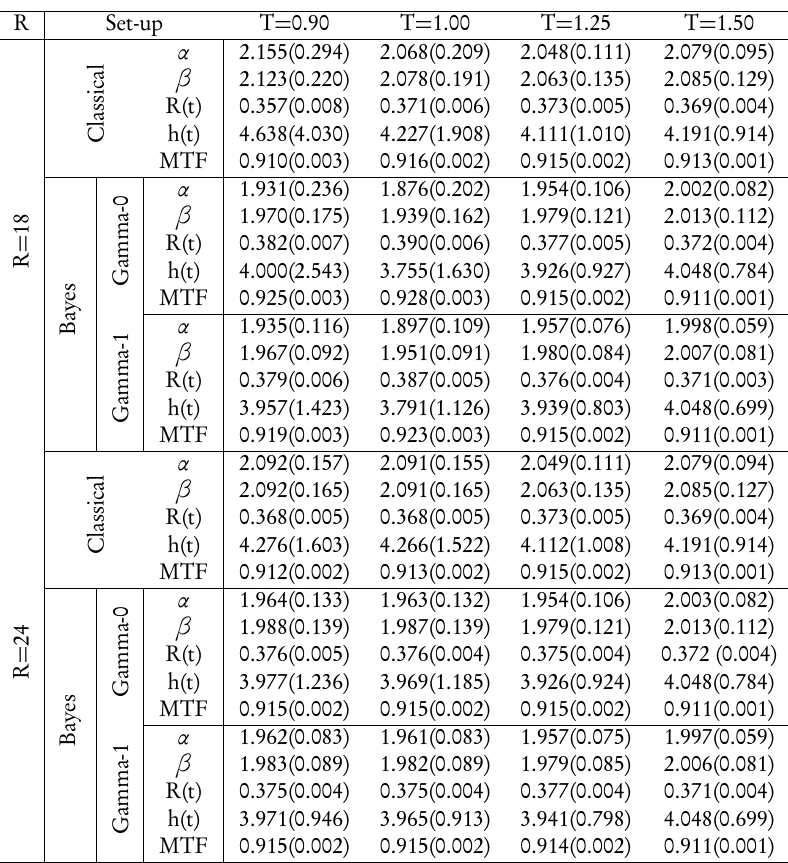
Average estimates of the parameters, reliability, hazard and MTF and corresponding MSEs (in brackets) with varying R and T for fixed n = 30 , α = 2 , β = 2 , R ( 1 ) = 0.3678 , h ( 1 ) = 4 and MTF = 0.9104